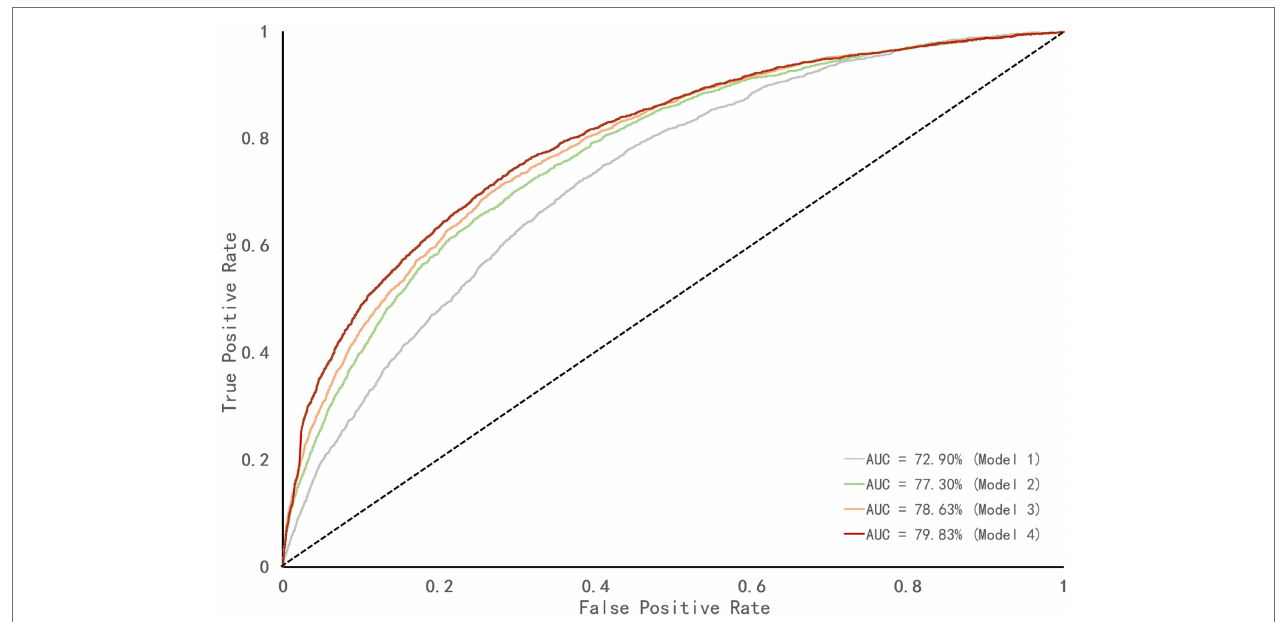
FIGURE 3 | The ROC curve of different logistic regression models in xG. The diagonal dotted line represents a line of zero discrimination, also known as pure chance line.